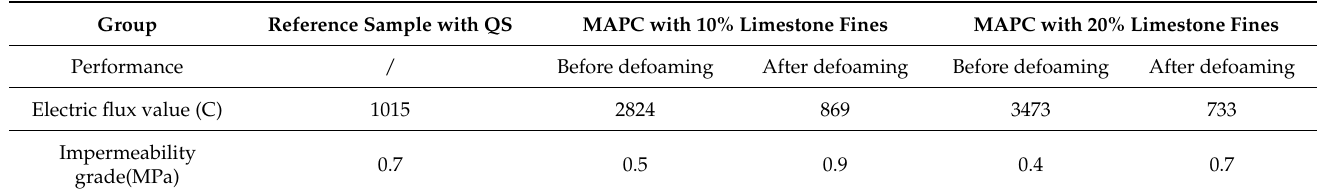
Table 1. Performance on resistance to chloride ion penetration and water-tightness of MAPC mortar with limestone fines (at content of 10% and 20%) or quartz sand (QS).